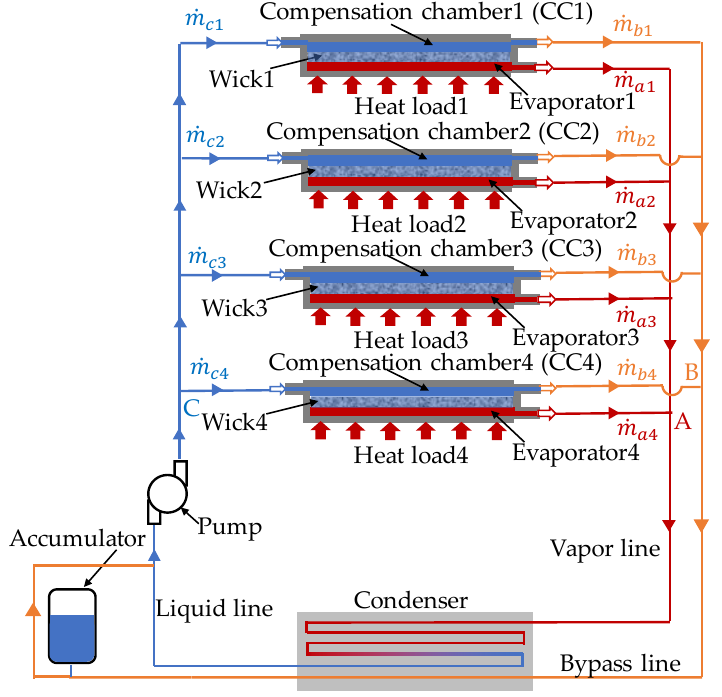
Figure 1. Schematic of a wick-type 2PMPFL with four evaporators (not to scale).